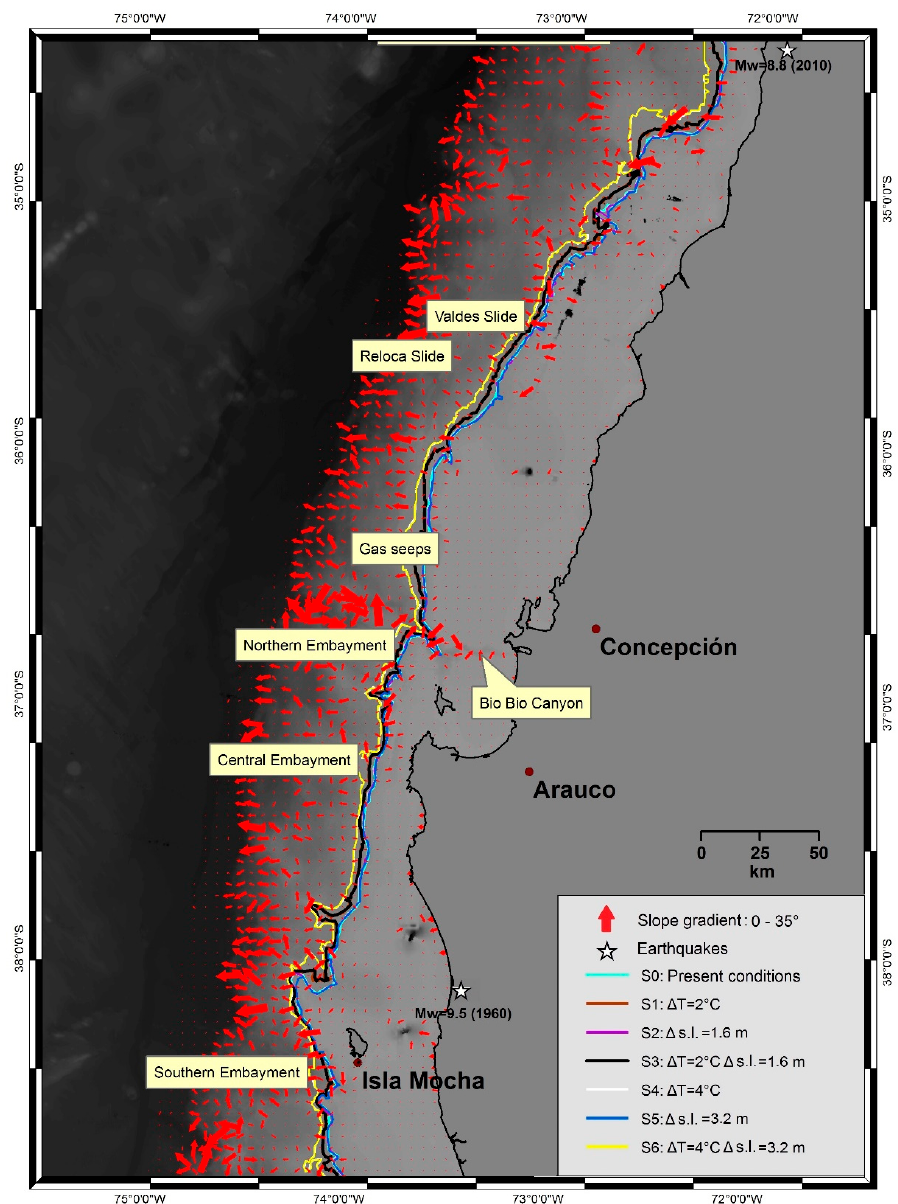
Figure 6. Study area between 35° S–38° S. The solid colored lines represent the intersections between the base of the GHSZ and the seafloor for each scenario. Here, the intersections are related to the slope gradient, marked by red arrows; the main slope failures are mapped, and major recent earthquakes are marked by stars.